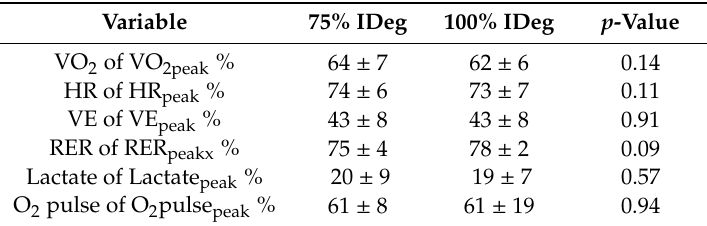
Table 2. Continuous exercise testing